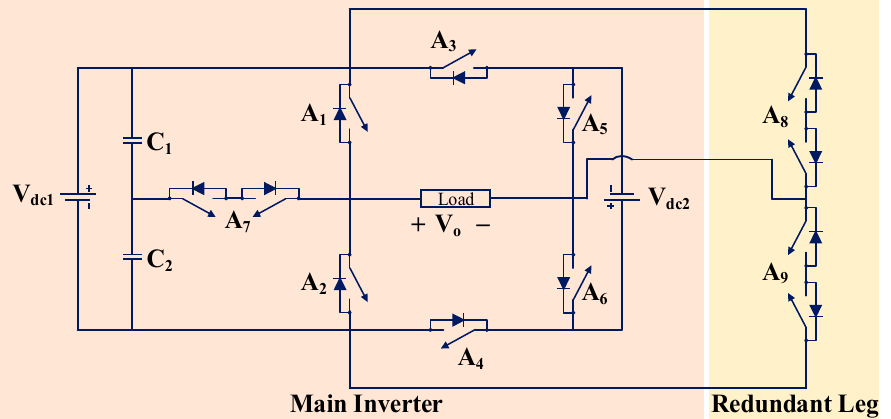
Figure 40. Single-phase nine-level FT MLI (TP43) [75].